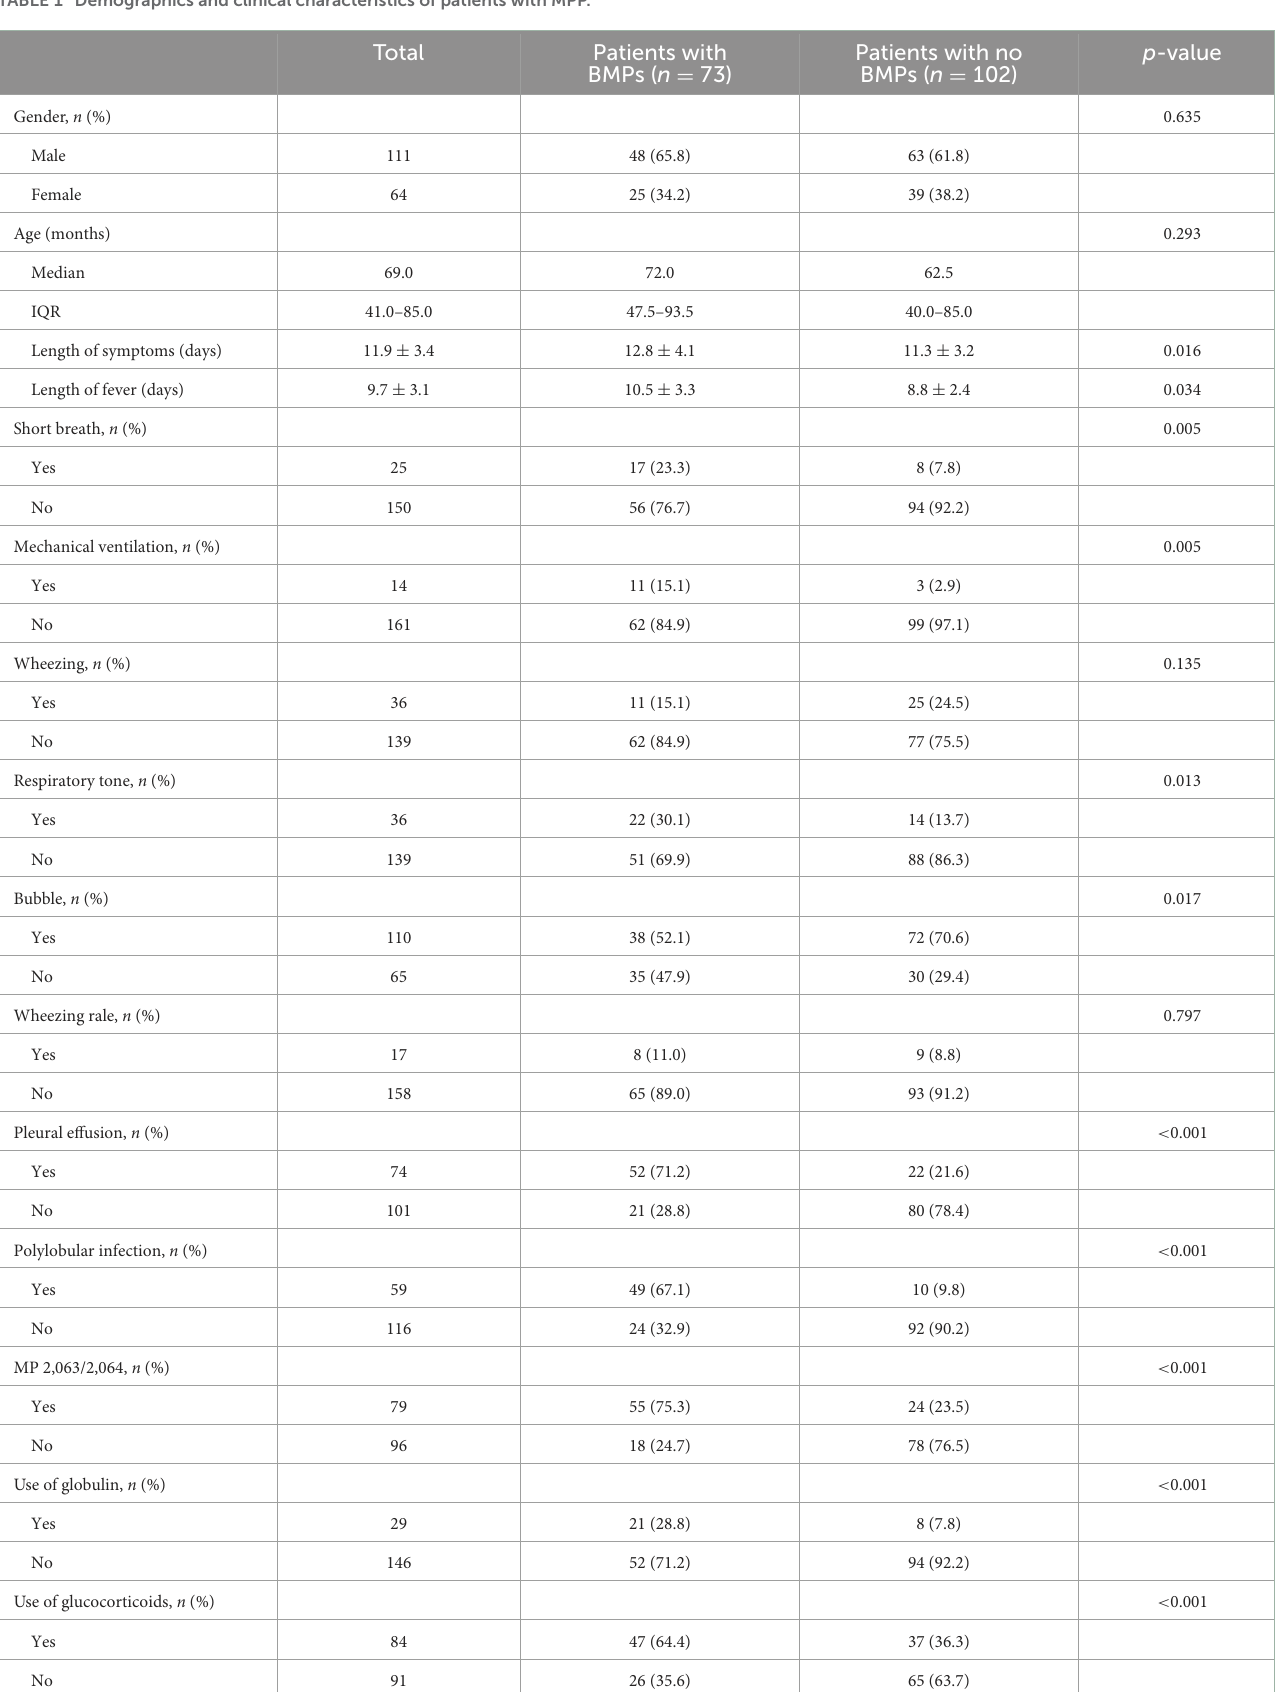
TABLE 1 Demographics and clinical characteristics of patients with MPP.